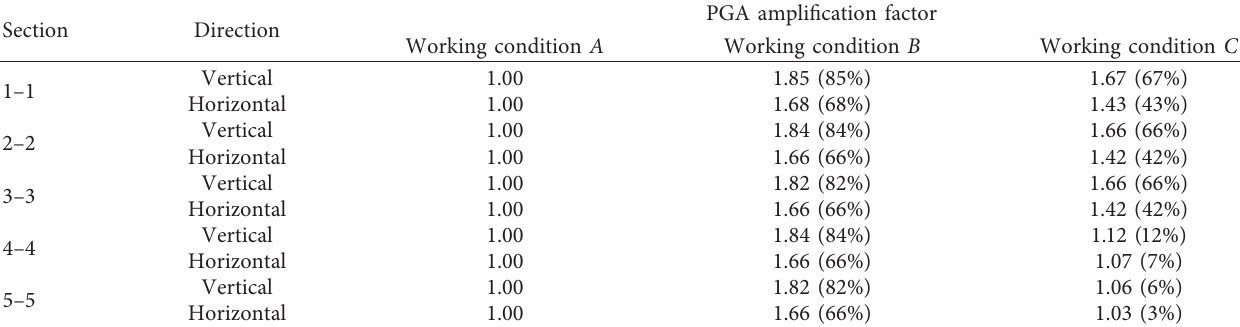
Table 6: Amplification factors of PGA.